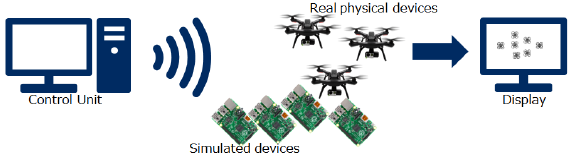
Figure 2. Parts of the demonstration platform: control unit, physical devices, simulated devices and a visualization module.